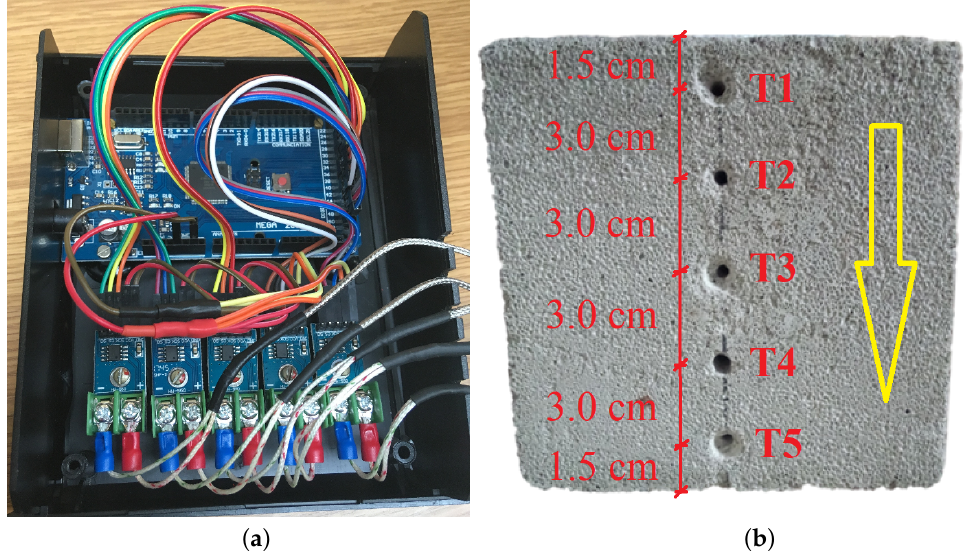
Figure 5. ( a ) The subassemblies inside the temperature acquisition unit ( b ) Schematic of the arrange- ment of the temperature measuring transducers in holes drilled in the sample.